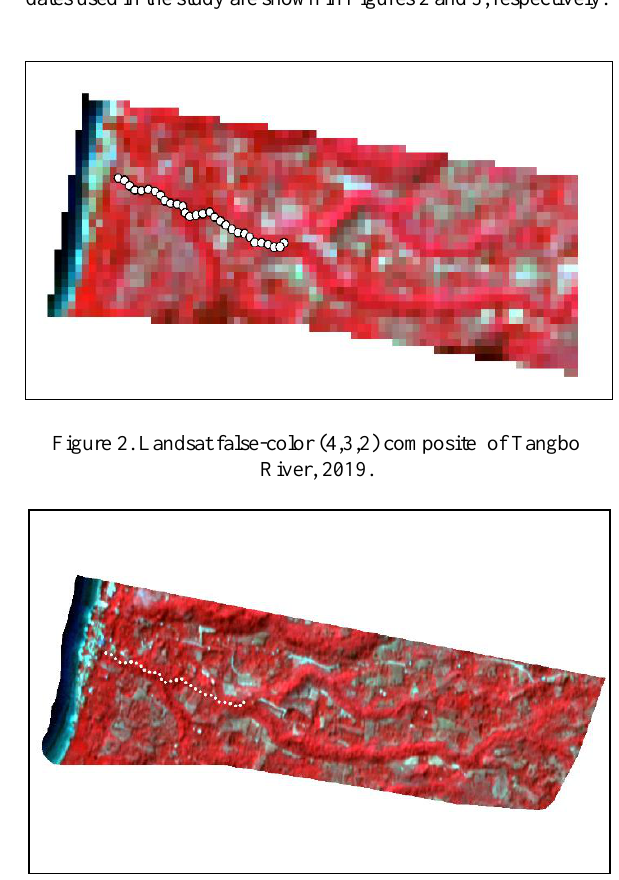
Figure 3. Planetscope false-color (4,3,2) composite of Tangbo River,